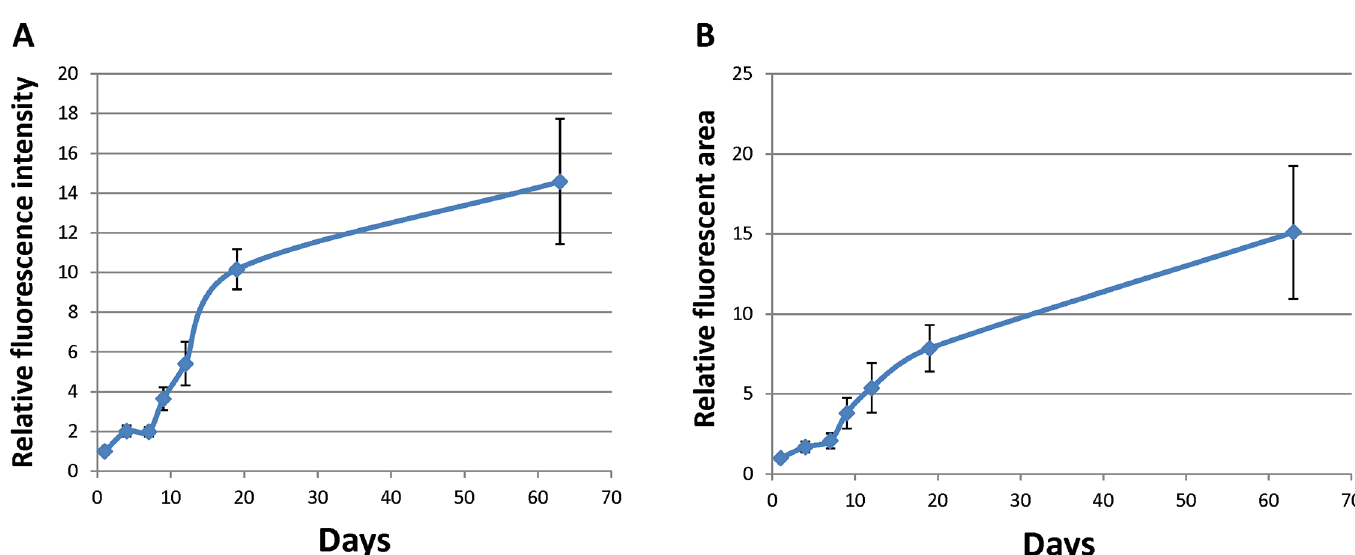
Fig 3. Graph quantifying the time-course increase of hair follicle stem cell GFP fluorescence intensity (A) and fluorescent area (B). p < 0.01 in increase of fluorescent area and fluorescence intensity at day 63 compared to day 1.